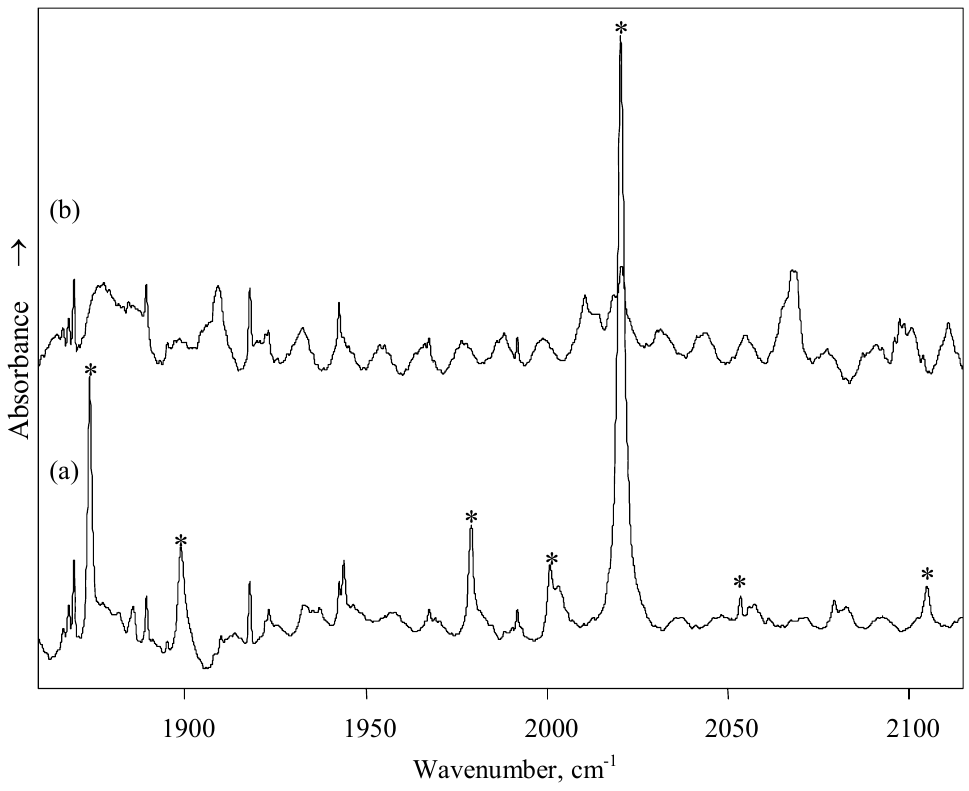
Fig. 7 (a) Selected region of infrared absorption spectrum of ethene SOZ isolated Ar matrix with combination bands and overtones. (b) the spectrum of the same sample after UV irradiation. * - denotes the combination bands or overtones of ethene secondary